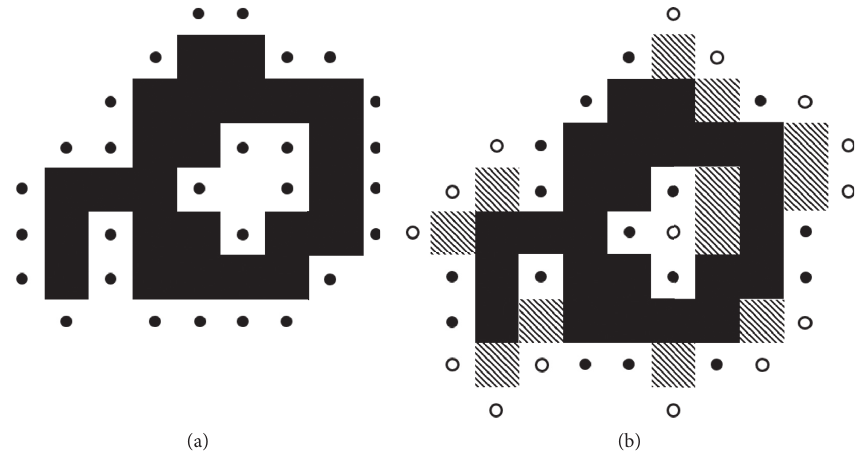
Figure 4: (a) The cluster (filled squares) and its interface (dots) after the k − 2th iteration step: Φ the number of dots. (b) The cluster (filled and striped squares) and its interface (dots and circles) after the k − 1th iteration step: Φ k − number of black and striped sites and I k − is the number of dots and circles. The striped sites are the recently occupied sites, while the circles 1 designate the new interface sites whose number is Δ I . The dots are now “extinct” interfacial sites.